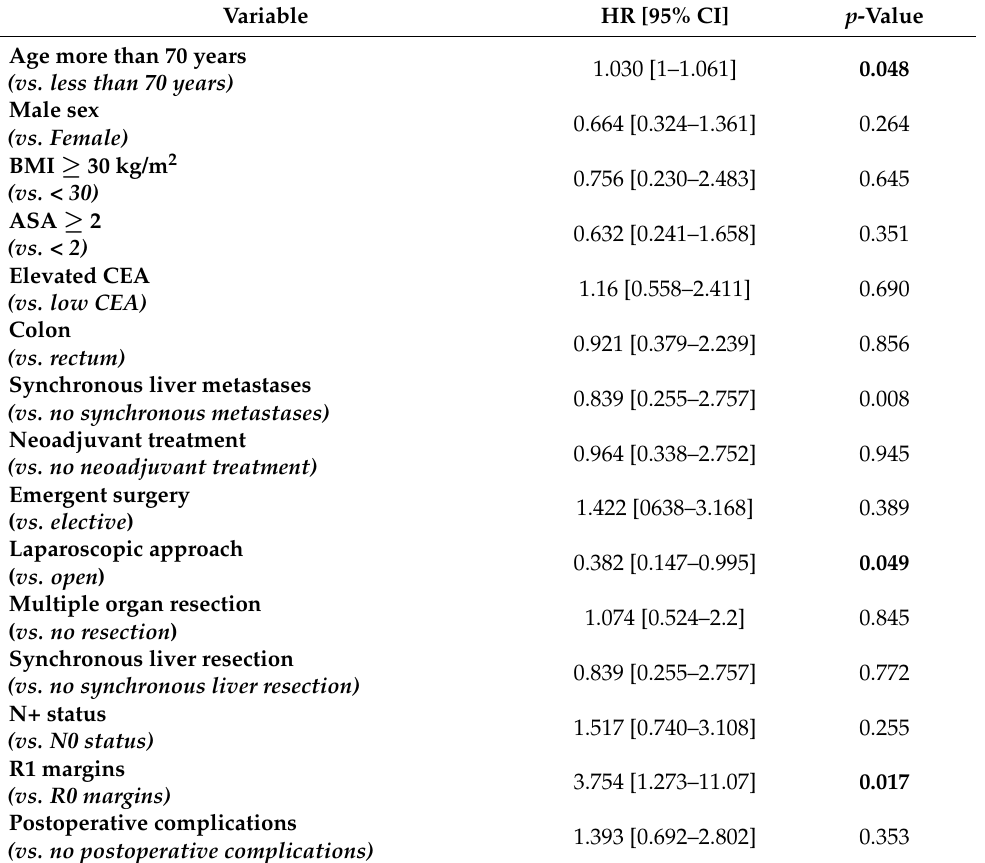
Table 4. Univariate analysis of baseline characteristics and management plan for overall survival in patients with T4 colorectal